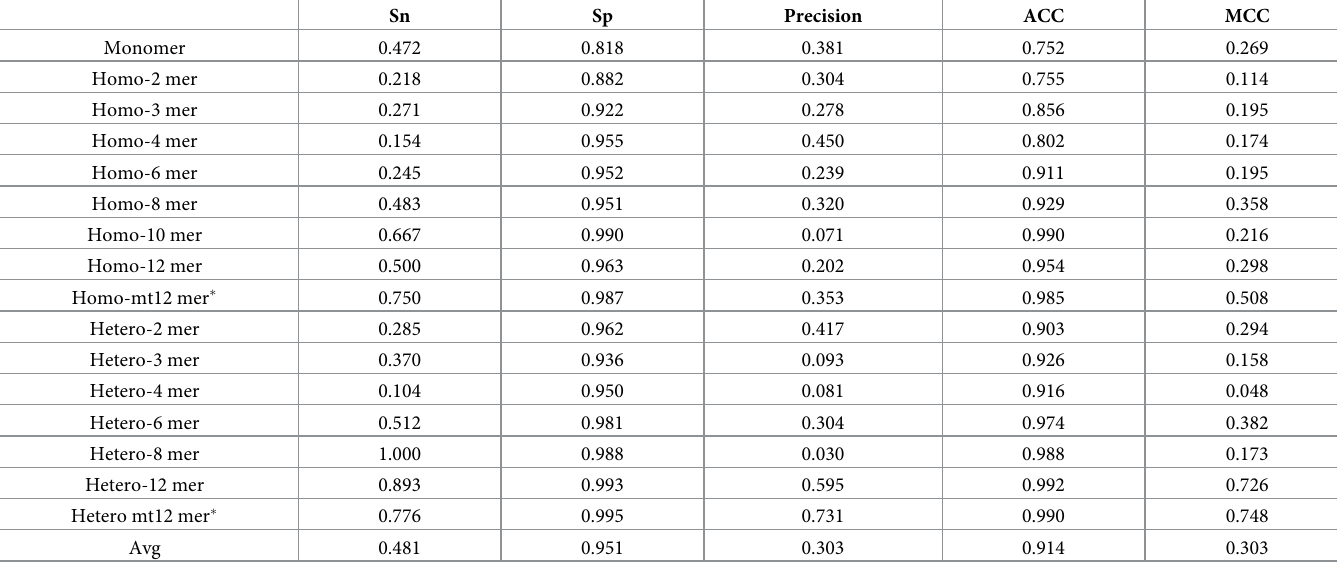
Table 5. Predicting results of best classifier of stage 1 classifier with independent testing. Sn Sp Precision ACC